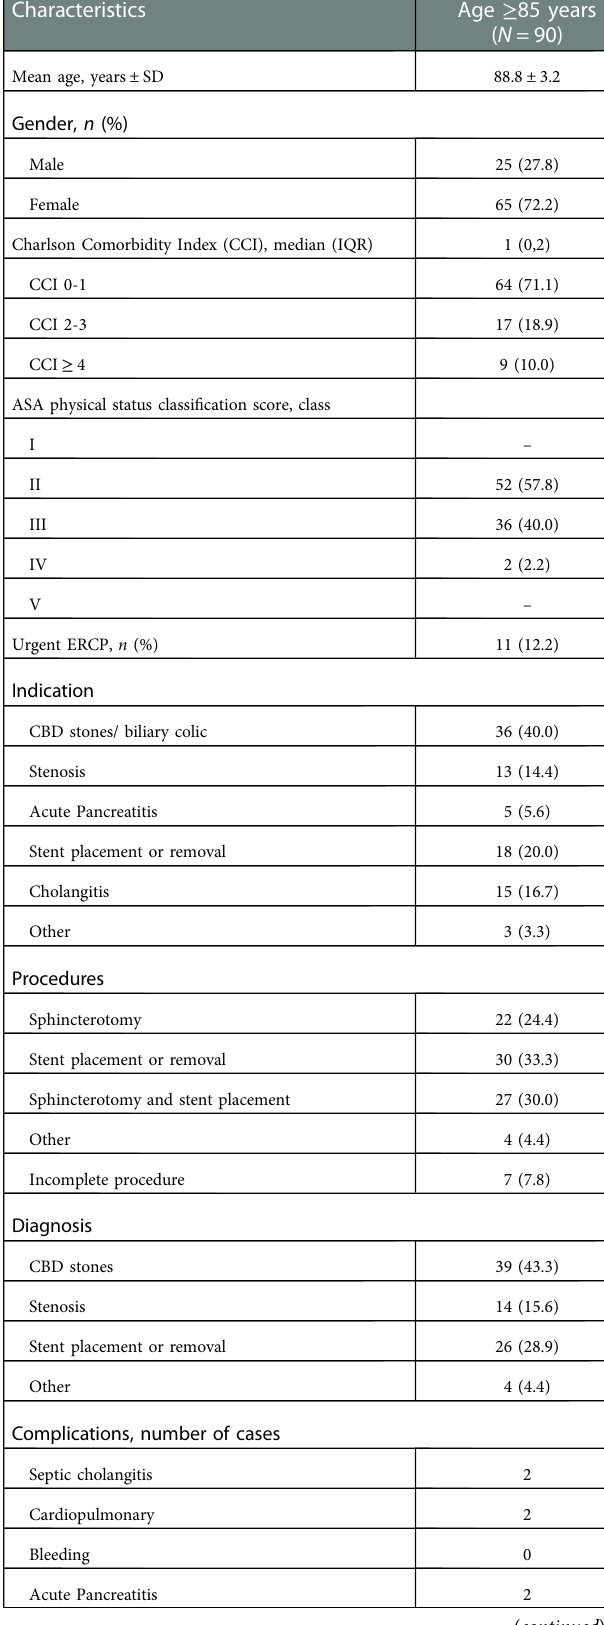
TABLE 1 Characteristics of patients aged 85 years and older undergoing ERCP, and list of their ERCP-related complications.